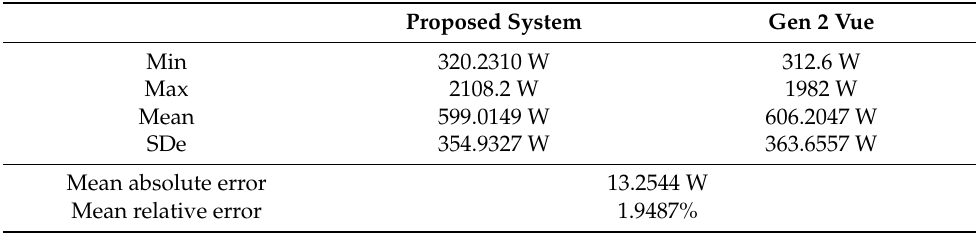
Table 9. Active power data in line 2 obtained by both monitors.